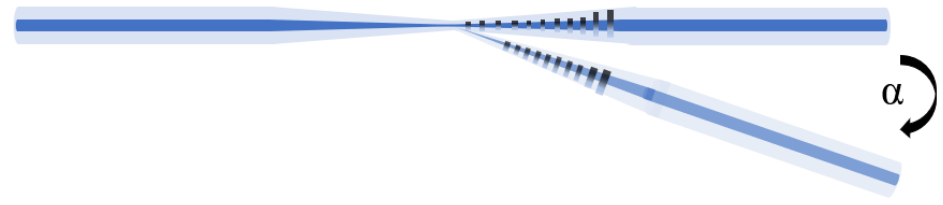
Figure 1. Schematic illustration of the inclinometer.